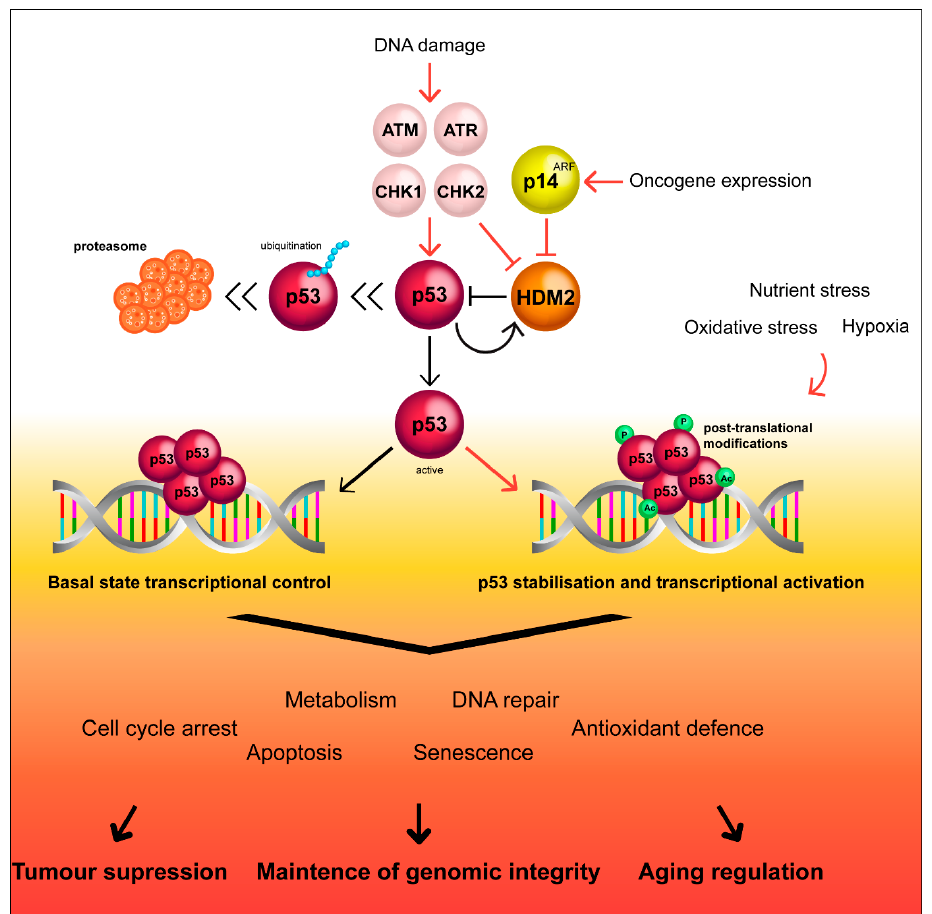
Figure 1. Simplified scheme of the p53 pathway and regulation by HDM2. HDM2 keeps p53 expression levels low, however, upon cellular stress, HDM2 can be regulated by complexing with p14 ARF , removing HDM2 mediated inhibition of p53. Moreover, kinases can coordinate the p53 response to stressors by inducing post-translational modifications that result in methylation, phosphorylation, acetylation, sumoylation, and ubiquitination of p53 occasioning in stability and transcriptional activation of this protein, maintaining genome